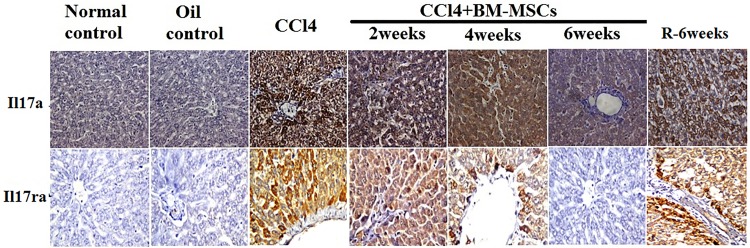
IL17A and IL17RA protein expression in liver tissue evaluated by IHC method.Upper panels are representatives of IL17 expression and it is noted that it was very weak in normal and paraffin/oil control group, severe in CCl4/fibrosis and recovery groups, high in CCl4+BM-MSCs/2 weeks group, moderate in CCl4+BM-MSCs/4weeks group and mild CCl4+BM-MSCs/6 weeks group. Lower panels are representatives of IL17RA expression and it is noted that it was absent in normal and paraffin/oil control group, high in CCl4/fibrosis and recovery groups, moderate in CCl4+BM-MSCs/2weeks group, mild in CCl4+BM-MSCs/4weeks group and nil in CCl4+BM-MSCs/6 weeks group (400X).